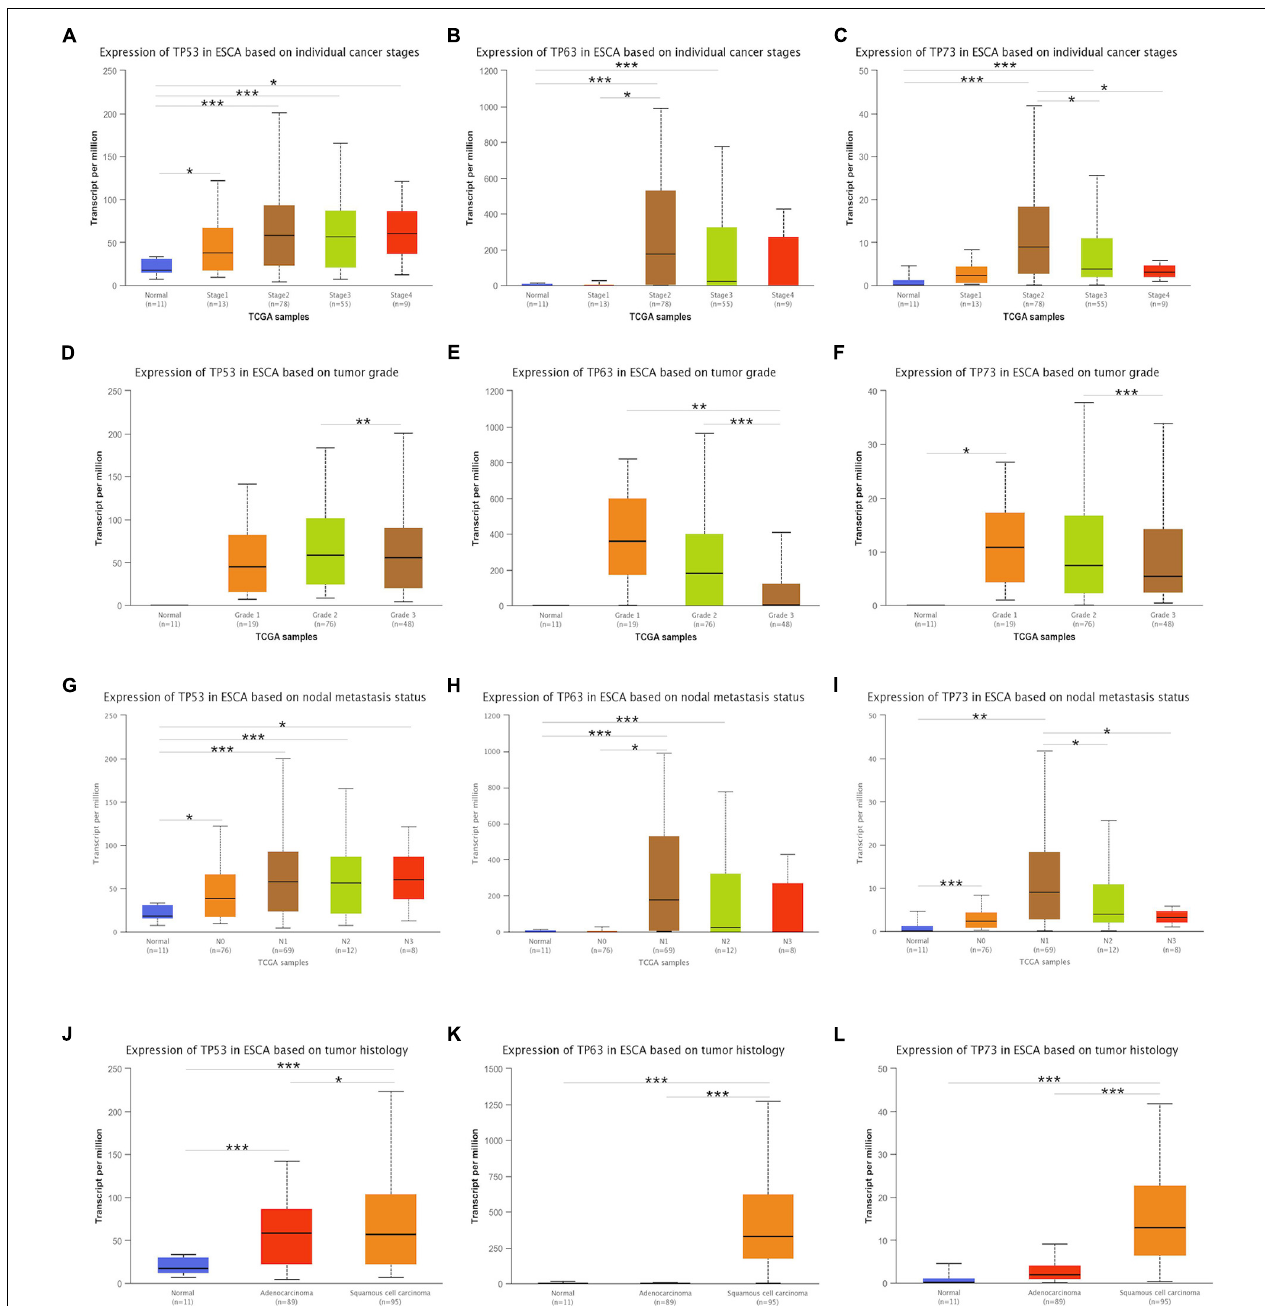
FIGURE 2 | Association between transcriptional expressions of TP53 family members and clinical parameters. The transcriptional expressions of TP53 family members associated with cancer stages, tumor grade, nodal metastasis status, and tumor histology (A–L) . * indicates p < 0.05, ** indicates p < 0.01, and *** indicates p <